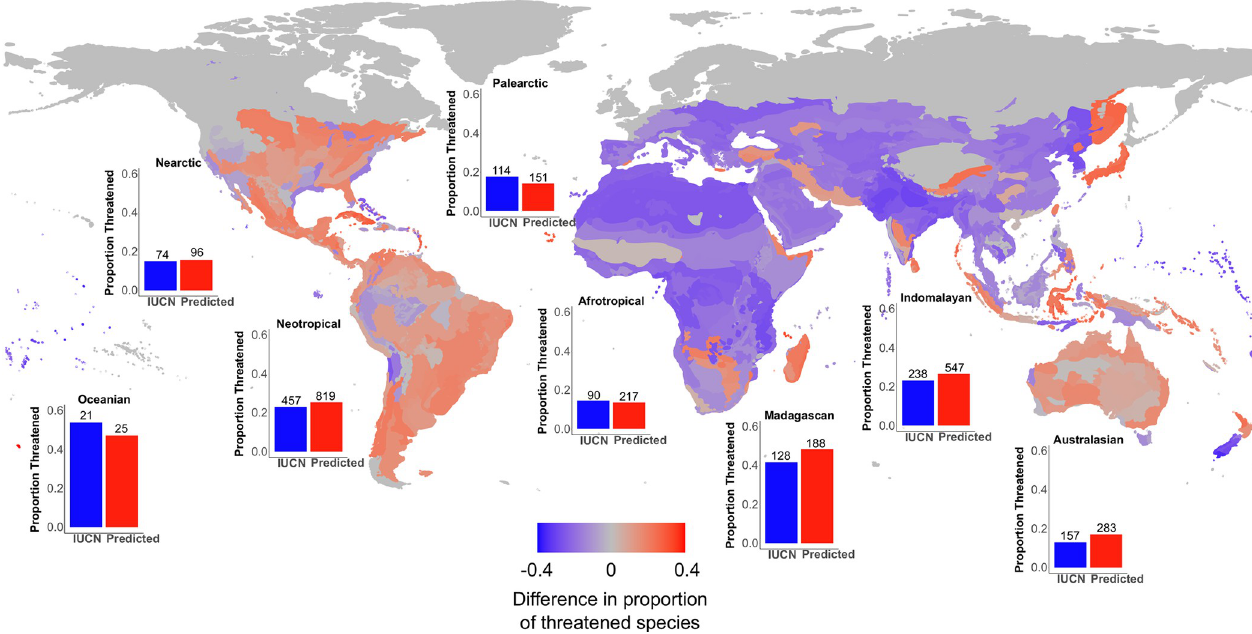
Fig 3. Global spatial changes in the percentage of threatened reptile species resulting from our automated assessments. The spatial data are grouped by WWF terrestrial ecoregions. The shift between red and blue is proportional to the (symmetric log scale) increase/decrease in extinction risk per ecoregion when using our assessments. Bar plots indicate proportion of species in threatened categories for each biogeographical realm, before and after the inclusion of automated assessments. The data underlying this figure can be found in S2 Data. IUCN, International Union for Conservation of Nature; WWF, World Wide Fund for